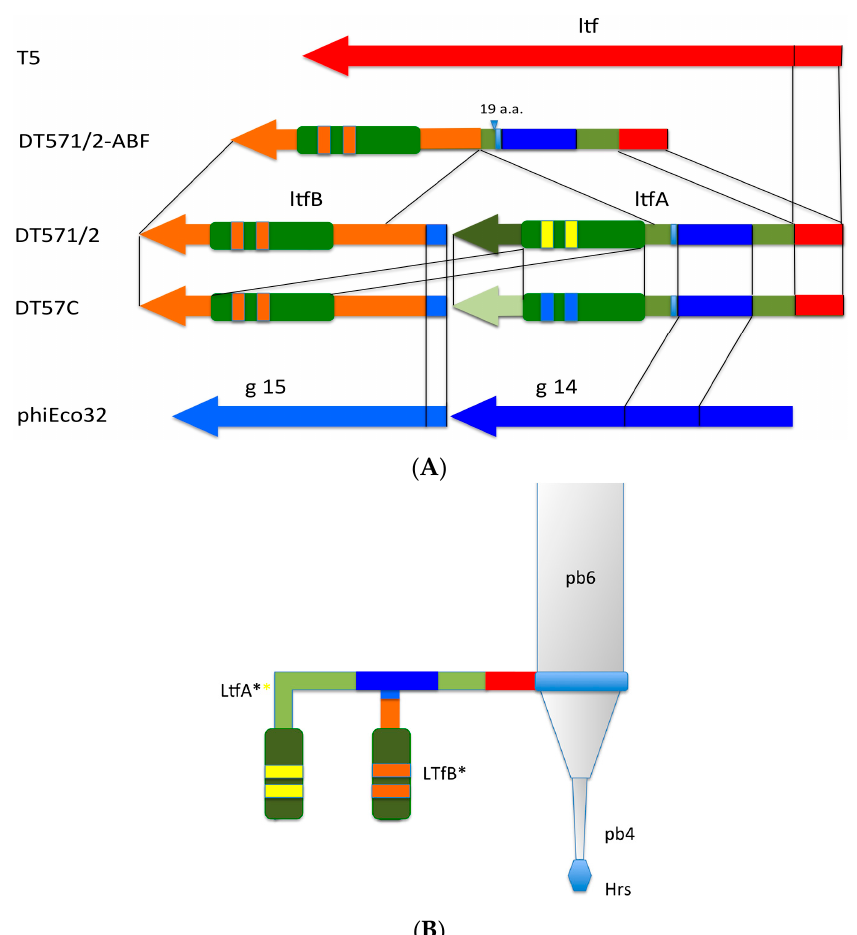
Figure 4. ( A ) Organization of the tail fiber loci in bacteriophages T5, DT57C, DT57-1/2, DT571/2-ABF, and (partially) phiEco32. The similarity of the a.a. sequence regions in LTFs of T5-like phages with other viruses are indicated by similar colors. The green rectangles with double bars indicate the receptor binding regions in Ltf proteins, the colors of these double bars indicate one of the three types of the Ltf receptor recognition domains: yellow LtfA-DT571/2, blue LtfA-DT57C, orange LtfB specific for O81-like O22-like and to O87-like OPS, respectively. Narrow light blue band indicates the block of tandemly repeated 19 a.a. motifs in LtfA protein; ( B ) Proposed model of the branched LTF organization. Only one of three LTFs is shown. The asterisk indicates that corresponding protein is proteolitically processed. The thick rectangles with double bars indicate the receptor binding regions in Ltf proteins. Dark blue and light blue parts stay for the regions of homology with phiEco32 phage gp 14 and gp 15, respectively, red part—the region of homology to phage T5 Ltf.